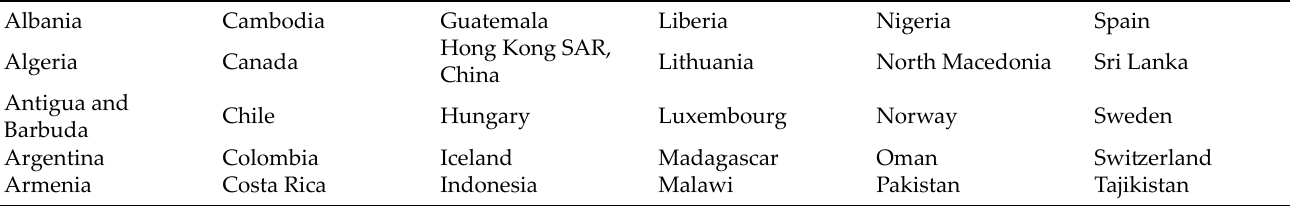
Table 1. List of economies included in this